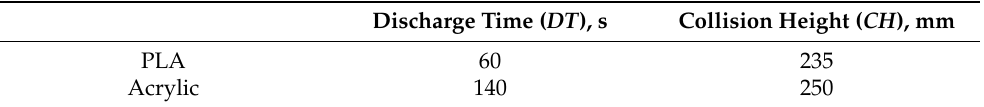
Table 7. Experimental results of the discharge-drop test.